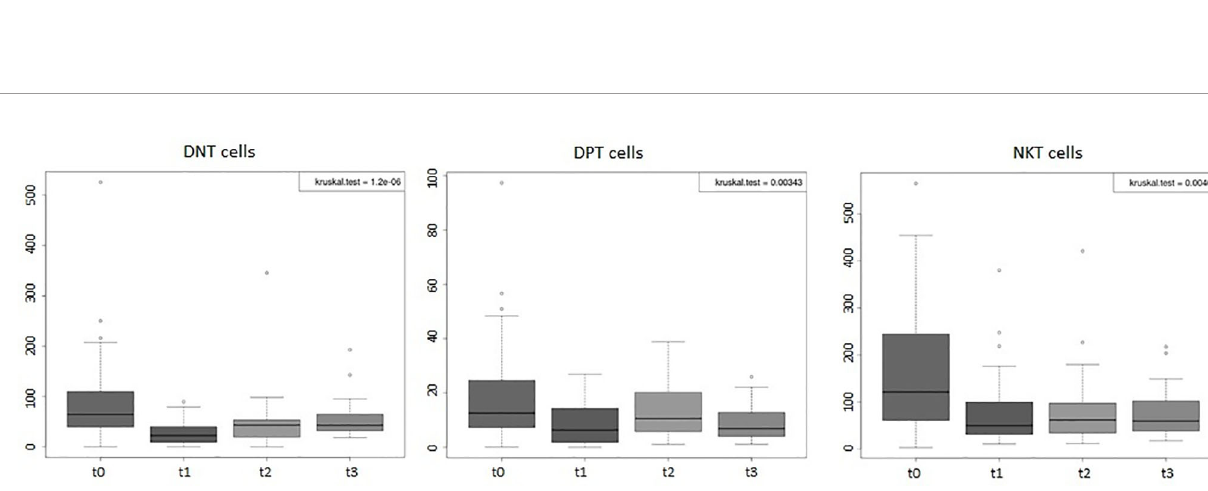
FIGURE 3 | Boxplots of the percentages, among total lymphocytes, of total T, B, NK, Tregs, T CD4, and T CD8 cells of the entire group of prostate cancer patients (44) undergoing curative RT. The data shown evidenced variations statistically signi fi cant during the four time points considered (Kruskal – Wallis test, p -value < 0.05), except for T CD8+ cells that did not undergo signi fi cant changes. t0: before RT; t1: end of RT; t2: 3 months after RT; t3: 6 months after